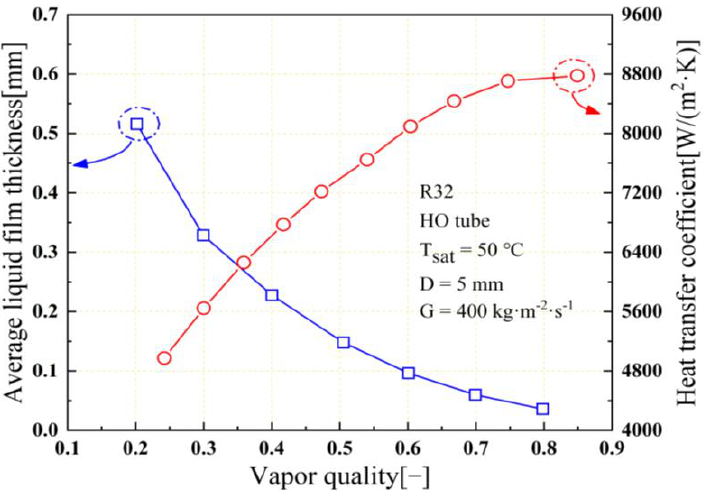
Figure 8. Distribution of average liquid film thickness and heat transfer coefficient under different vapor quality.